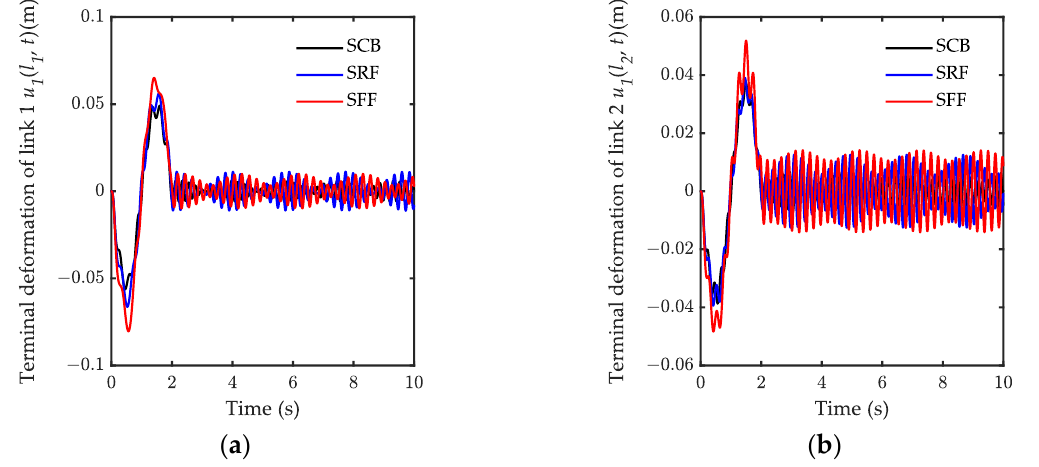
Figure 8. The terminal deformations of the two links: ( a ) the terminal deformation of link1; ( b ) the terminal deformation of link 2.